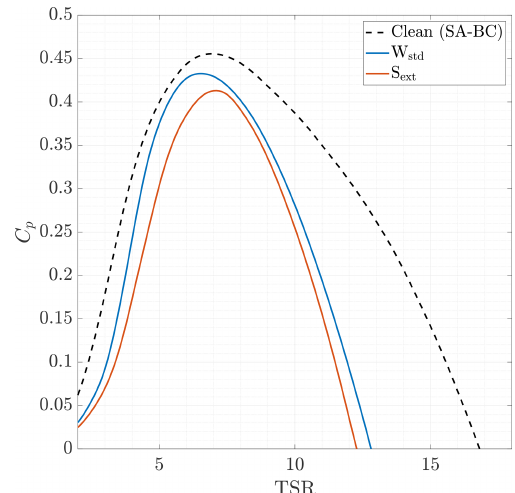
Figure 23. C P –TSR curves with pitch angle β = 0 ◦ . Figure 24. Power curve with a steady inflow.